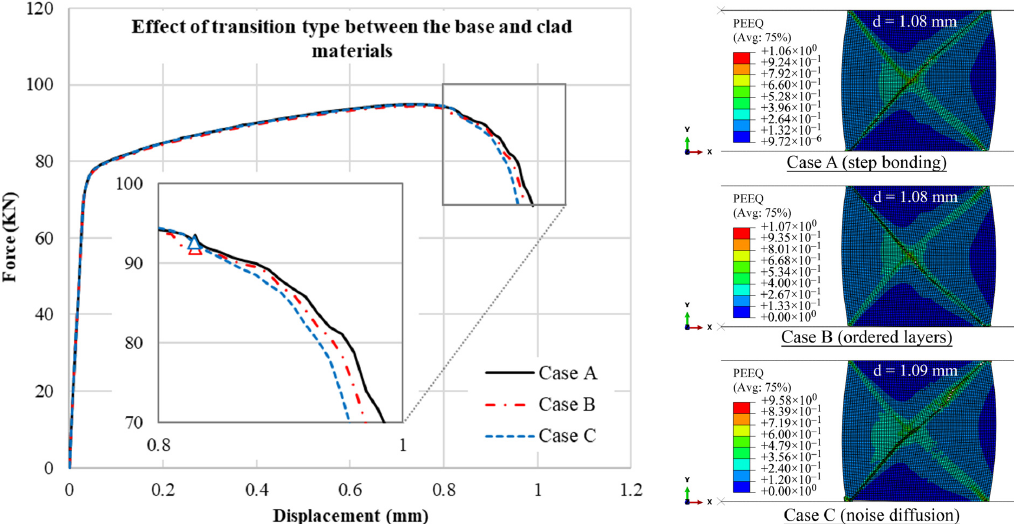
Figure 17. Effect of transition type on crack propagation, in terms of f–d curves and distribution of equivalent plastic strain at displacement level of: d = 1.08 mm for Case A, d = 1.08 mm for Case B, and d = 1.09 mm for Case C.